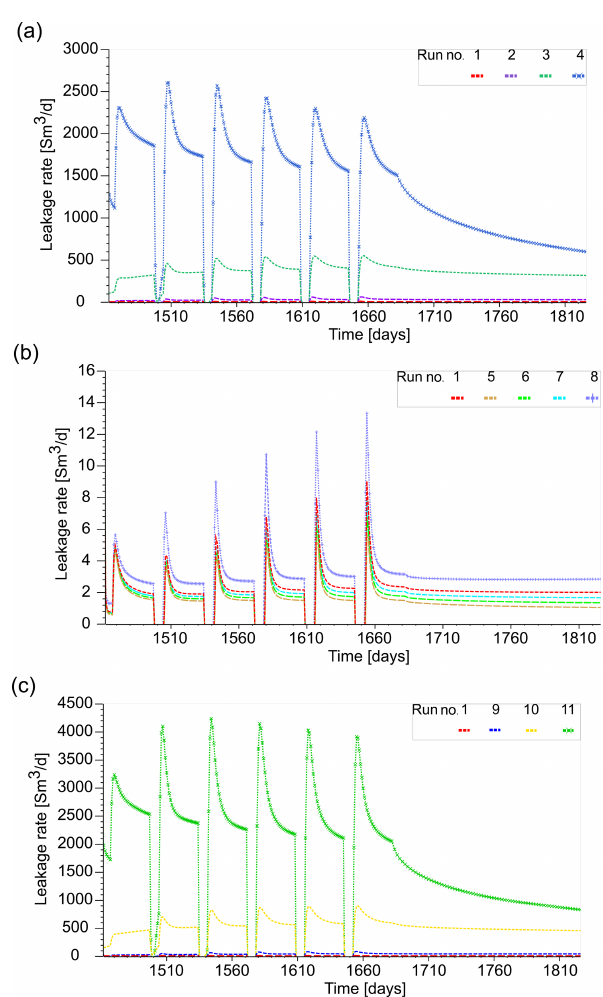
Figure 6. Gas leakage rates during six injection periods for: (a) sce- nario I – damage zone permeability cases; (b) scenario II – capillary entry pressure cases; (c) scenario III – normalised capillary